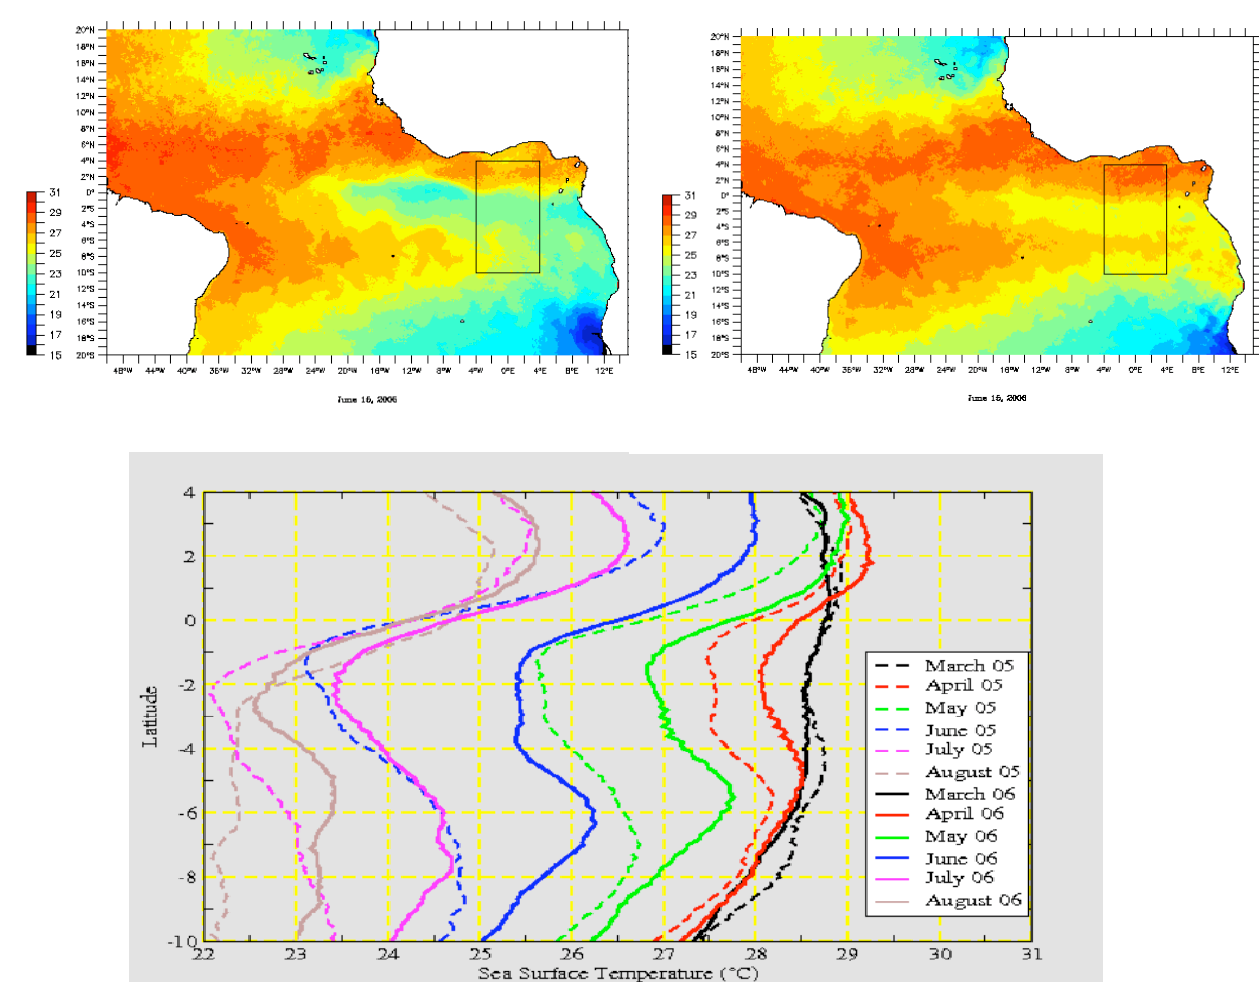
Figure 14. Upper left : SST from OSISAF (http://www.osi-saf.org/index.php) on 15 th June 2005. Upper right : SST from OSISAF on 15 th June 2006. Bottom : Meridional cross-section of monthly SST from OSISAF averaged between 4°W-4°E from March to August in 2005 and 2006. The domain where these data have been taken is indicated in the upper figures.